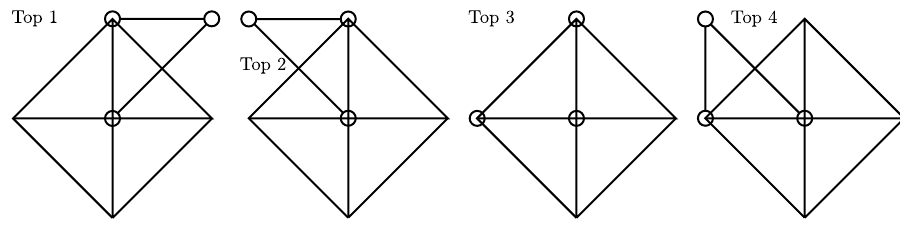
Figure 2 . The toric diagram of the four inequivalent SU(3) tops over F 2 .